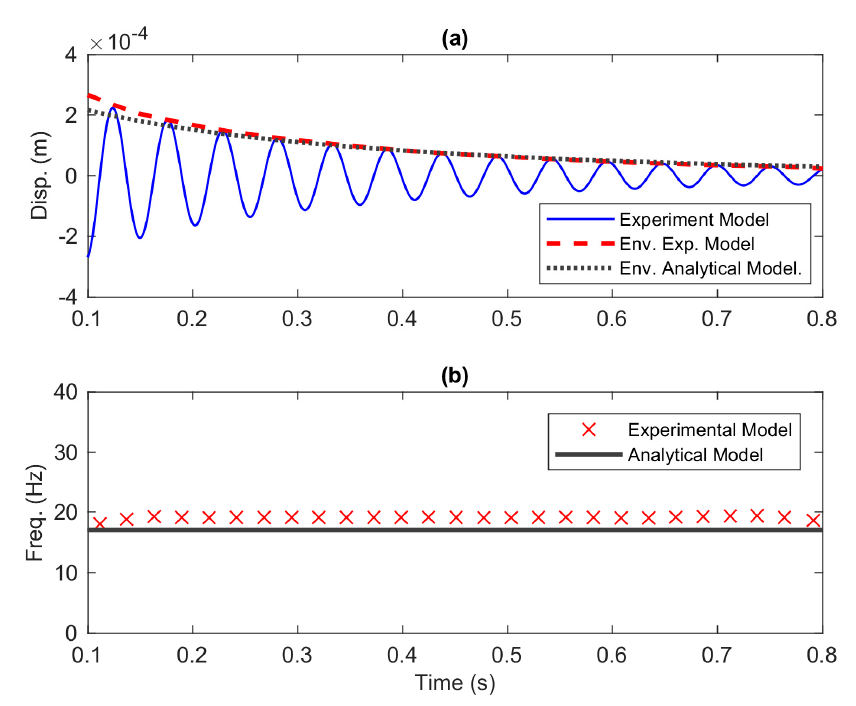
Figure 20. The time series of ( a ) displacement and ( b ) frequency.